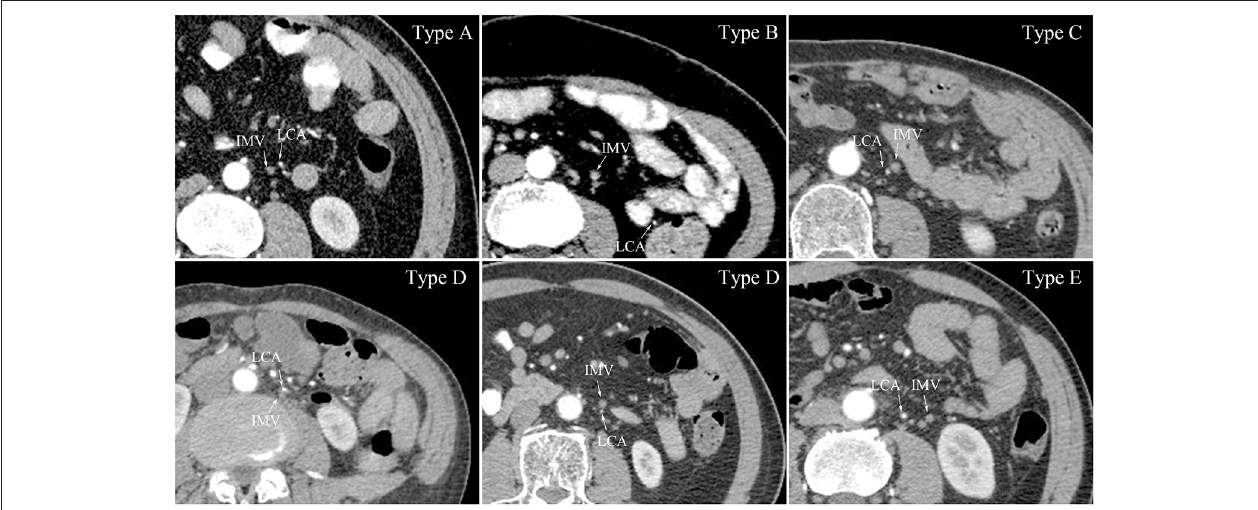
FIGURE 2 | LCA and IMV organisation at the level of the IMA origin. Type A, the LCA located just lateral to the IMV; Type B, the LCA located laterally distant from the IMV; Type C, the LCA located just medial to the IMV; Type D, the LCA located either anterior or posterior to the IMV; Type E, the LCA located medially distant from the IMV; LCA, left colic artery; IMV, inferior mesenteric